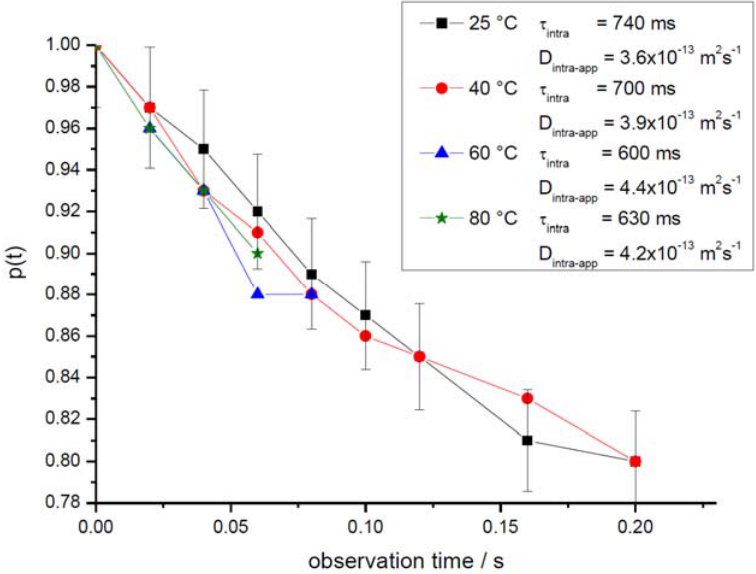
Figure 6. The fraction p ( t ) of molecules which, over the observation time t, remain in one and the same crystal (NMR tracer desorption (exchange) curve) as determined for different temperatures with propane as a guest molecule in the purely microporous zeolite NaCa-LTA-0. Indicated in the inset are the intracrystalline mean lifetimes following by applying Equations (10) and (12). Also shown are the (apparent) diffusivities which result via Equation (11) with the microscopically determined crystallite radius of about 2 μ m if the tracer desorption curves were analyzed by implying diffusion-limited tracer exchange.